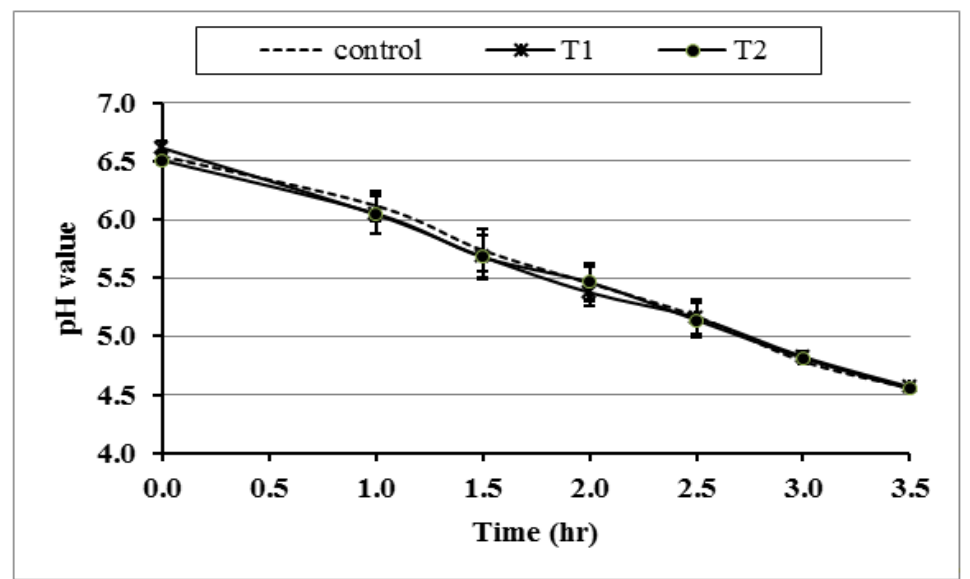
Figure 4. Effect of different concentrations of CrPi on the pH of the media during yoghurt fer- mentation. Control: without Cr (CrPi), T1: with 0.25 ppm Cr (CrPi), T2: fortified with 0.5 ppm Cr (CrPi). The data are shown as mean ± SE for three replicates.